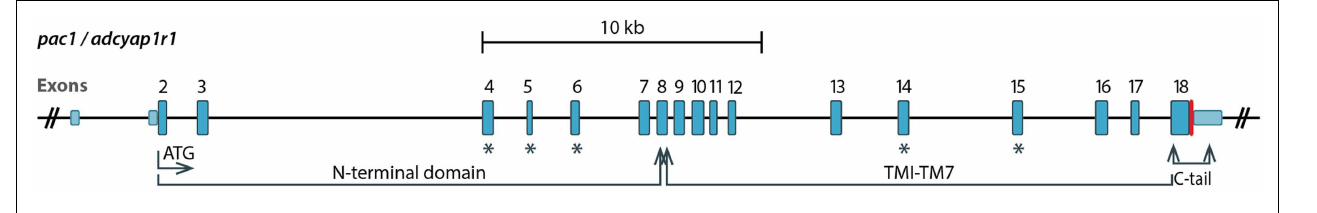
blue asterisks. Exon 4, 5, and 6 encode parts of the N-terminal domain, whereas exons 14 and 15 encode the third intracellular loop.TM,